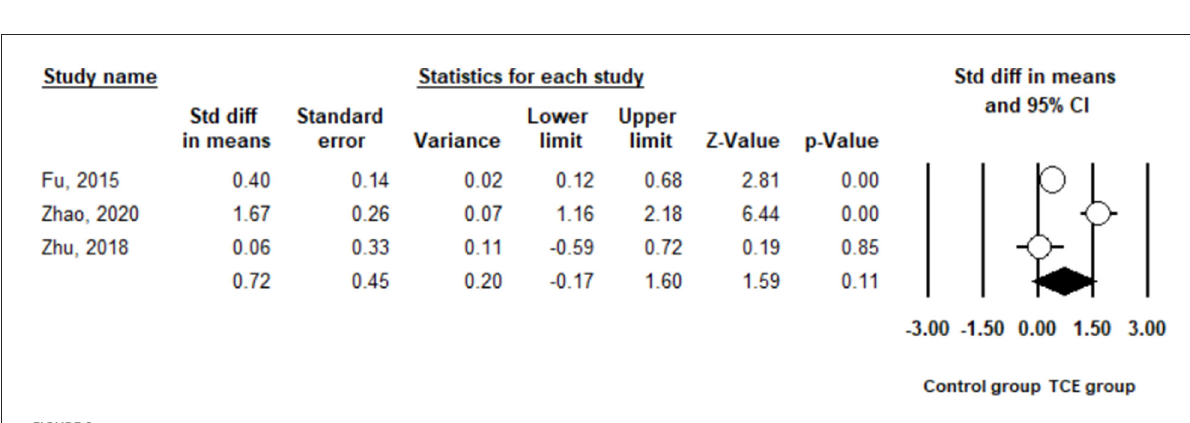
FIGURE8 The effect of Traditional Chinese exercises on the sleep